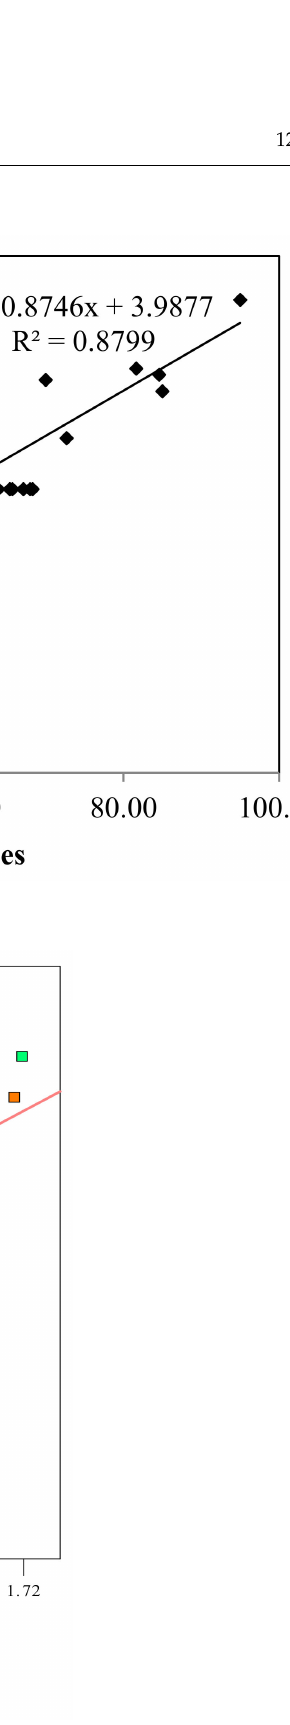
Figure 3. The normal % probability and studentized